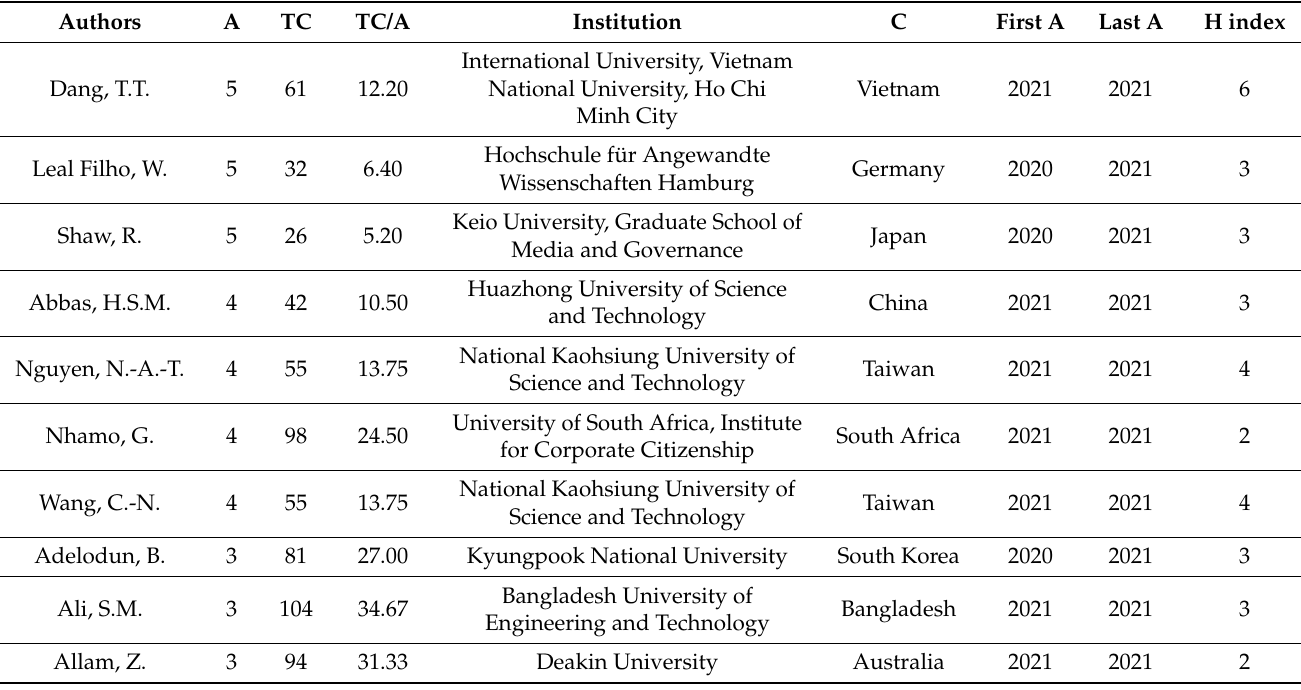
Table 4. The ten most productive